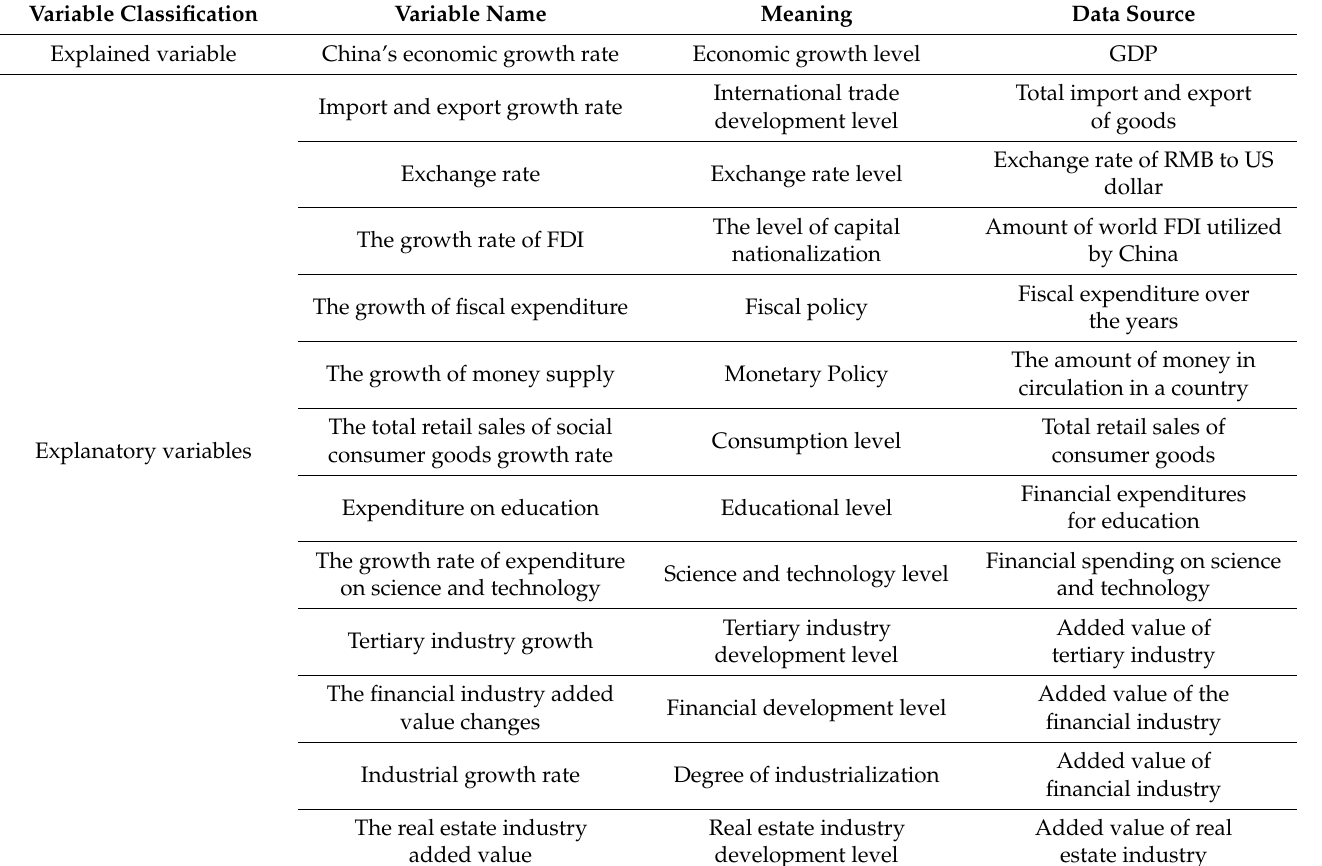
Table 1. Description of variables and